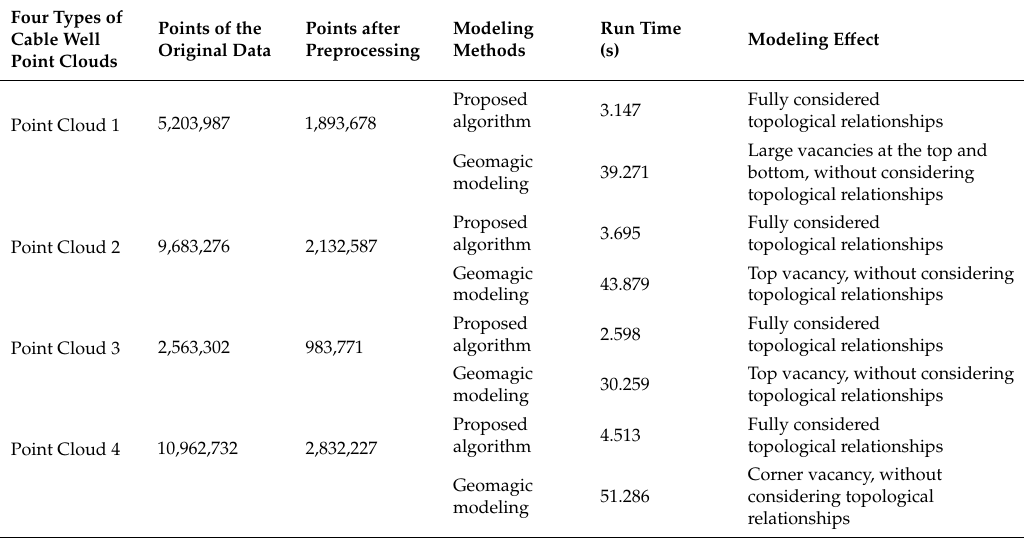
Figure 17. Construction of different cable well models. ( a ) Original point clouds, ( b ) fine modeling, and ( c ) this paper’s modeling method. Table 2. Generation time and modeling effect of different models.